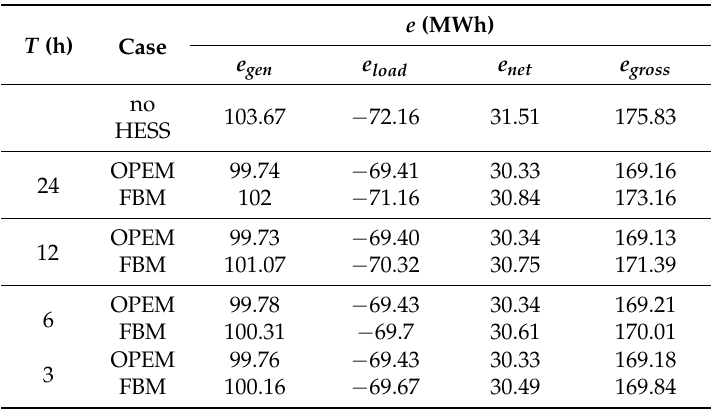
Table 11. Weekly energy analysis.